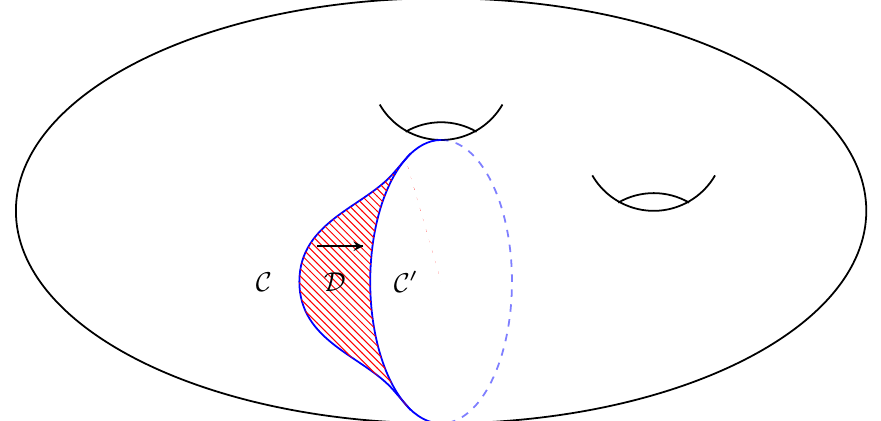
Figure 2: Deforming a symmetry defect line from the curve C across the domain D to the new curve C (cid:48)